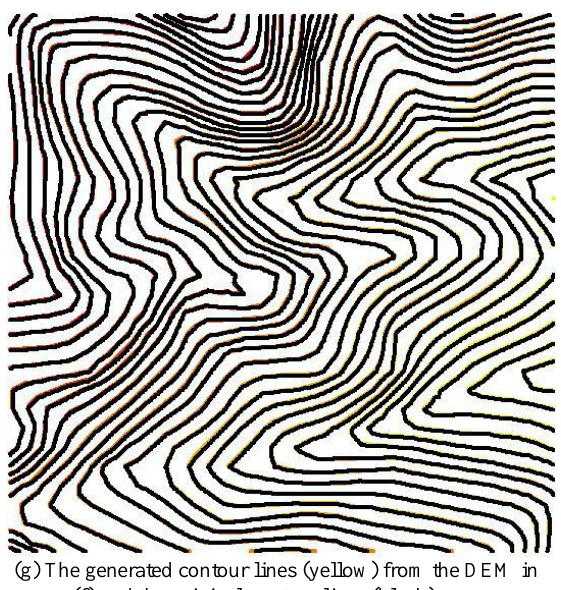
(g) The generated contour lines (yellow) from the DEM in (f) and the original contour lines (black) Figure 2 DEM interpolation from contour lines by integration of morphological reconstruction and Euclidean distance transformation with